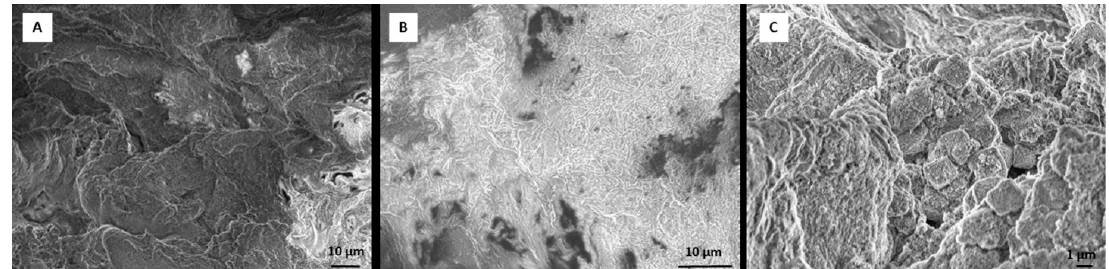
collected media confirmed with von Kossa staining.